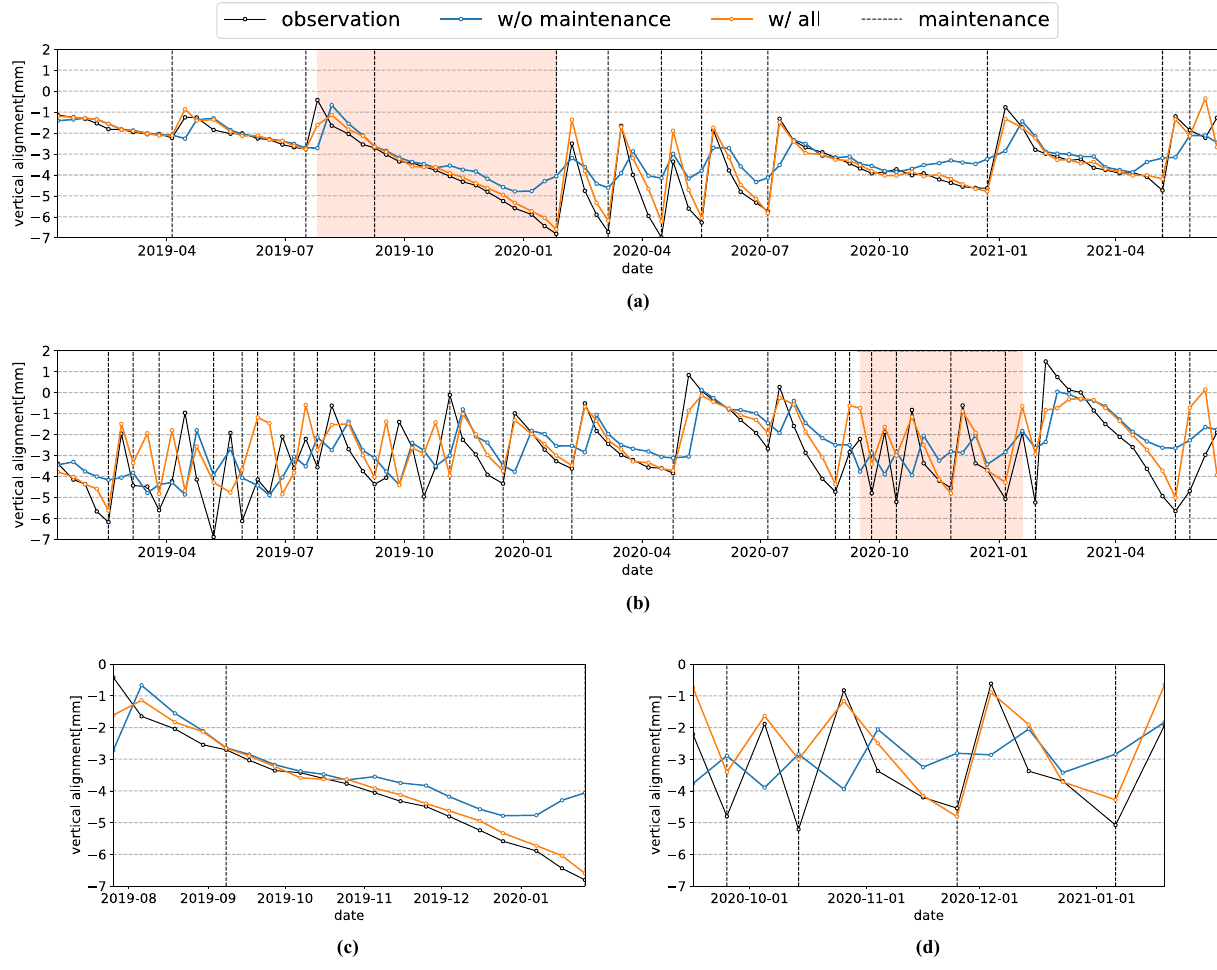
Figure 6. ( b , d ) Show the forecasted time series of a specific spatial point where maintenance is performed once every four inspections on average, that is, approximately once every month. At a spatial point with a high maintenance frequency, the forecasted time series of the “with-all” condition is typically closer to the observed time series than that of the “without-maintenance” condition. Forecasted time series of specific spatial points under “with-all” and “without-maintenance” conditions. The vertical dotted lines indicate the dates when maintenance operations were performed. ( a ) is the time series of a specific spatial point with a normal maintenance frequency. ( c ) is the orange part of ( a ). ( b ) is the time series of a specific spatial point with a high maintenance frequency. ( d ) is the orange part of ( b